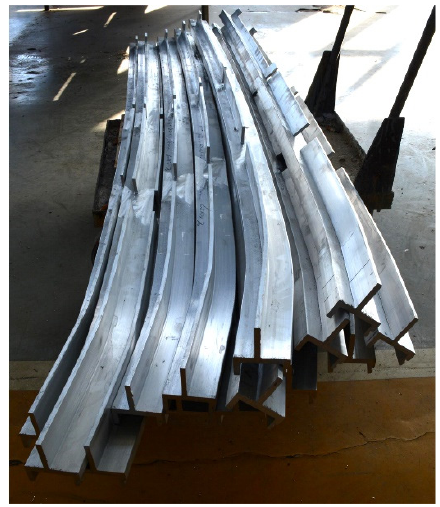
Figure 15. Comparison of maximum springback deviation.